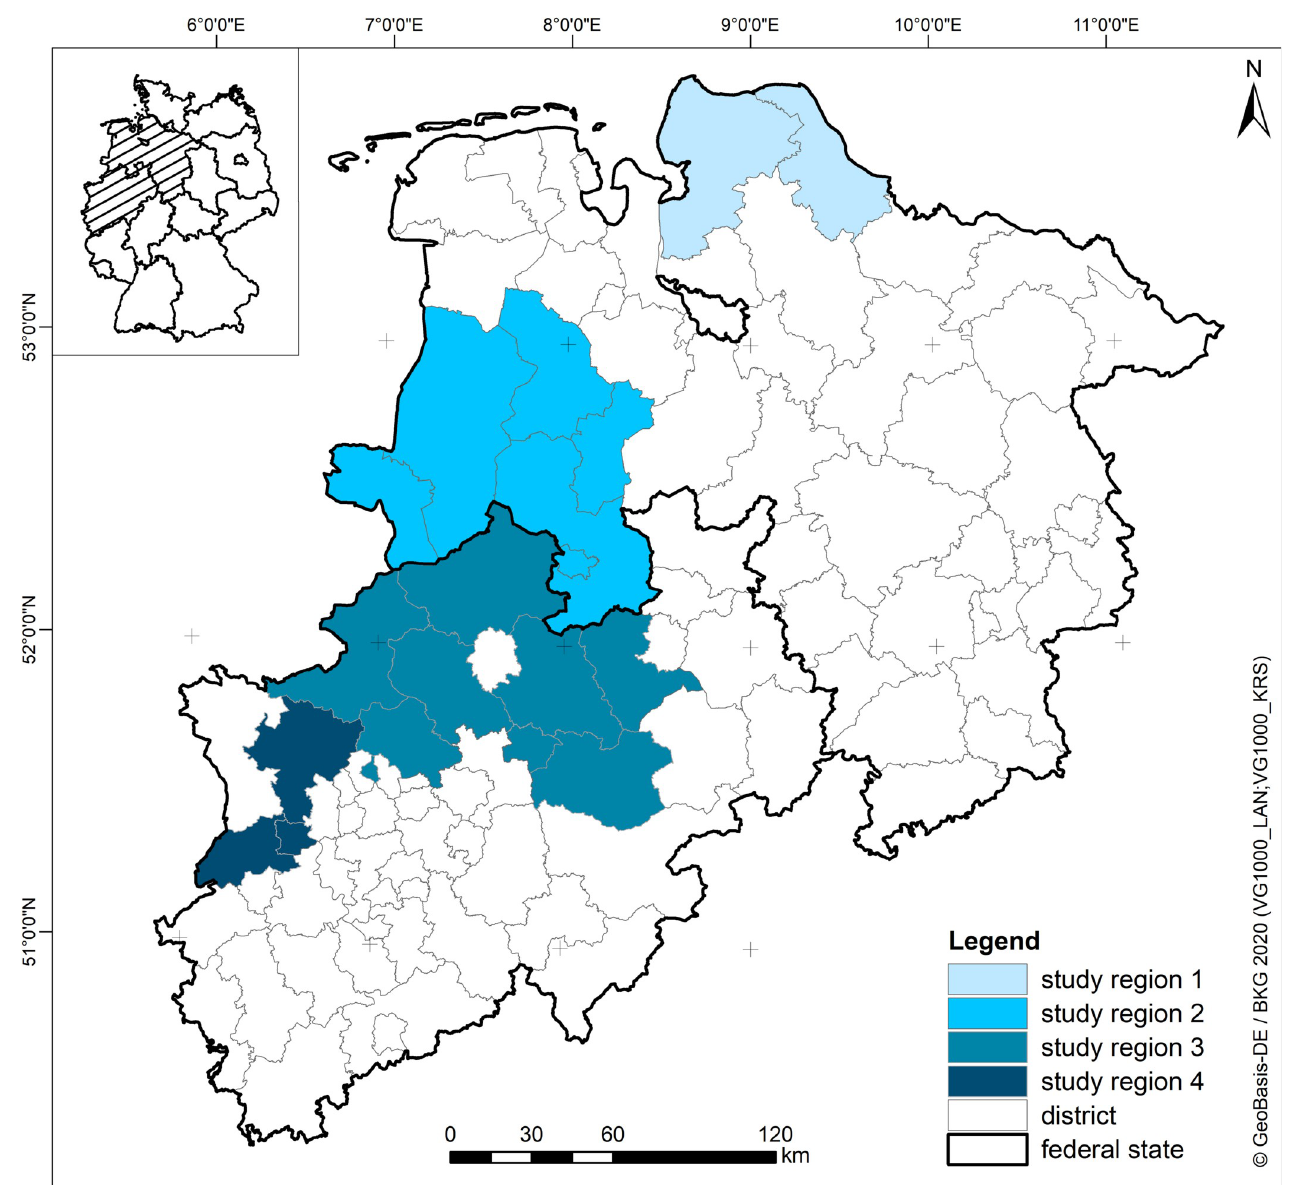
Fig 1. Sampling regions in Northwestern Germany. Situated in the federal states of Lower Saxony and North Rhine-Westphalia. (Fig 1) under the permit of LAVES 33.12 42502-04-12/0695. Blood samples were taken from Vena cutenea ulnaris superficialis and afterwards the birds were released into the wild again. Blood samples were centrifuged and the sera were stored at -20˚C for further investigation.